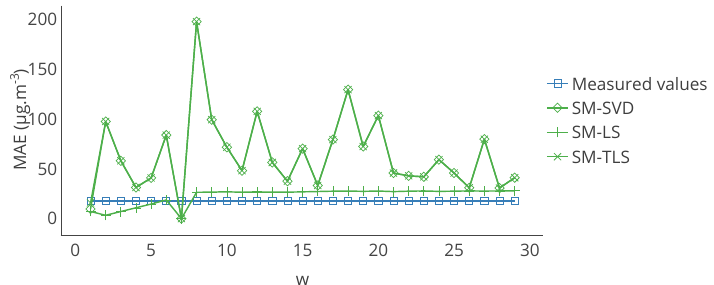
Figure 18. Evolution of the mean of MAE, computed on the entire time interval of study, over the network for the strategies SM-SVD, SM-LS and SM-TLS as a function of w with a different signal subspace than in Figure 17. The best results are still obtained for w = 7 but for most the values of w , the algorithms degrade the quality of the measurements and more significantly for SM-SVD and